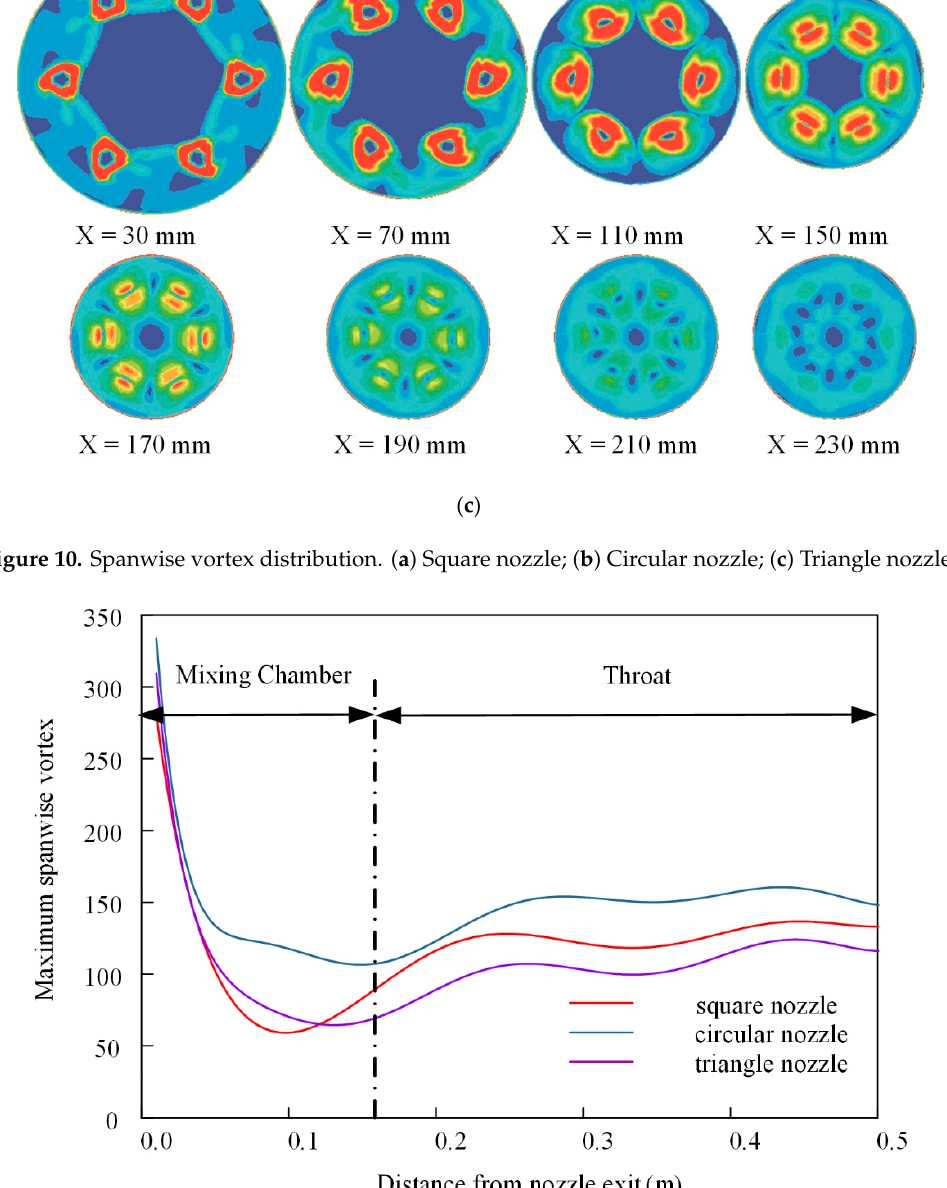
Figure 11. Decay of the maximum spanwise vorticity value.